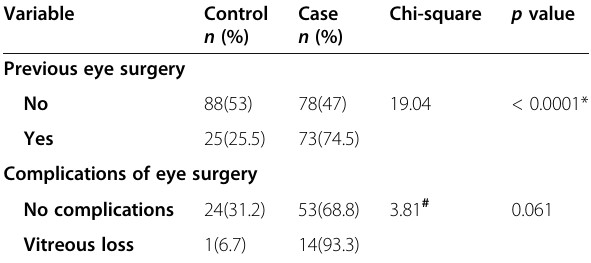
Table 4 Comparison between cases of retinal detachment and controls regarding previous eye surgery and its complications, Ain Shams Outpatient Ophthalmology clinic, Cairo, Egypt, 2018 Variable